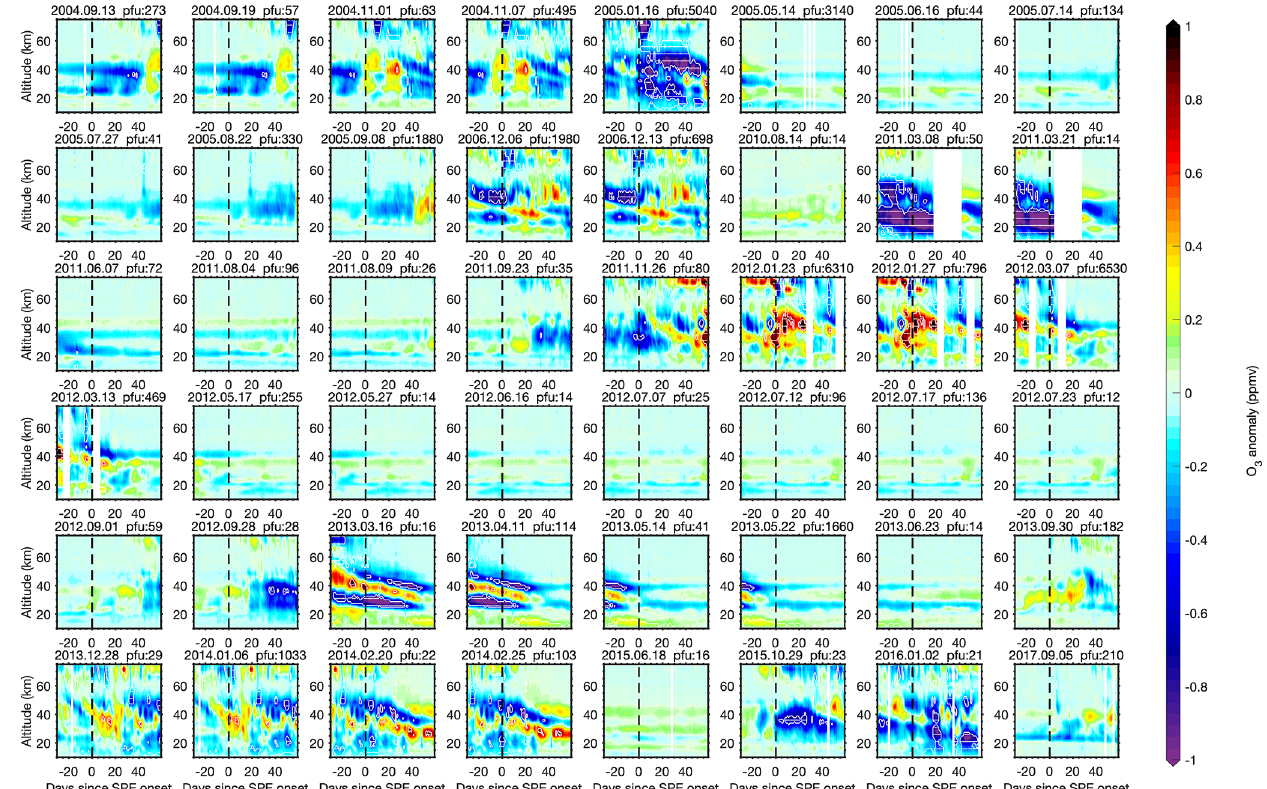
Figure A2. Same as Fig. 3 but after all individual SPEs since July 2004.